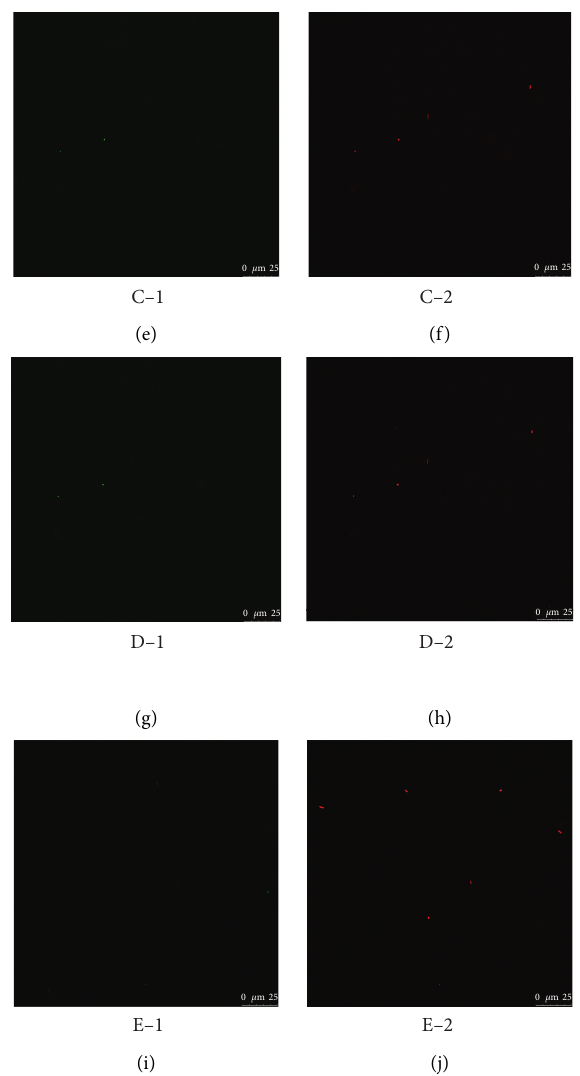
Figure 7: Confocal laser scanning microscope (CLSM) of P. antarctica at 1000 magnification. (a–e) CLSM images stained with AO, which are images of control, treatment by DMY at 0 MIC, 1 MIC, 2 MIC, and 4 MIC. (f–j) CLSM images stained with PI, which are images of control, treatment by DMY at 0 MIC, 1 MIC, 2 MIC, and 4 MIC. Nuclei of living cells show green fluorescence. Nucleic acids in apoptotic cells show red